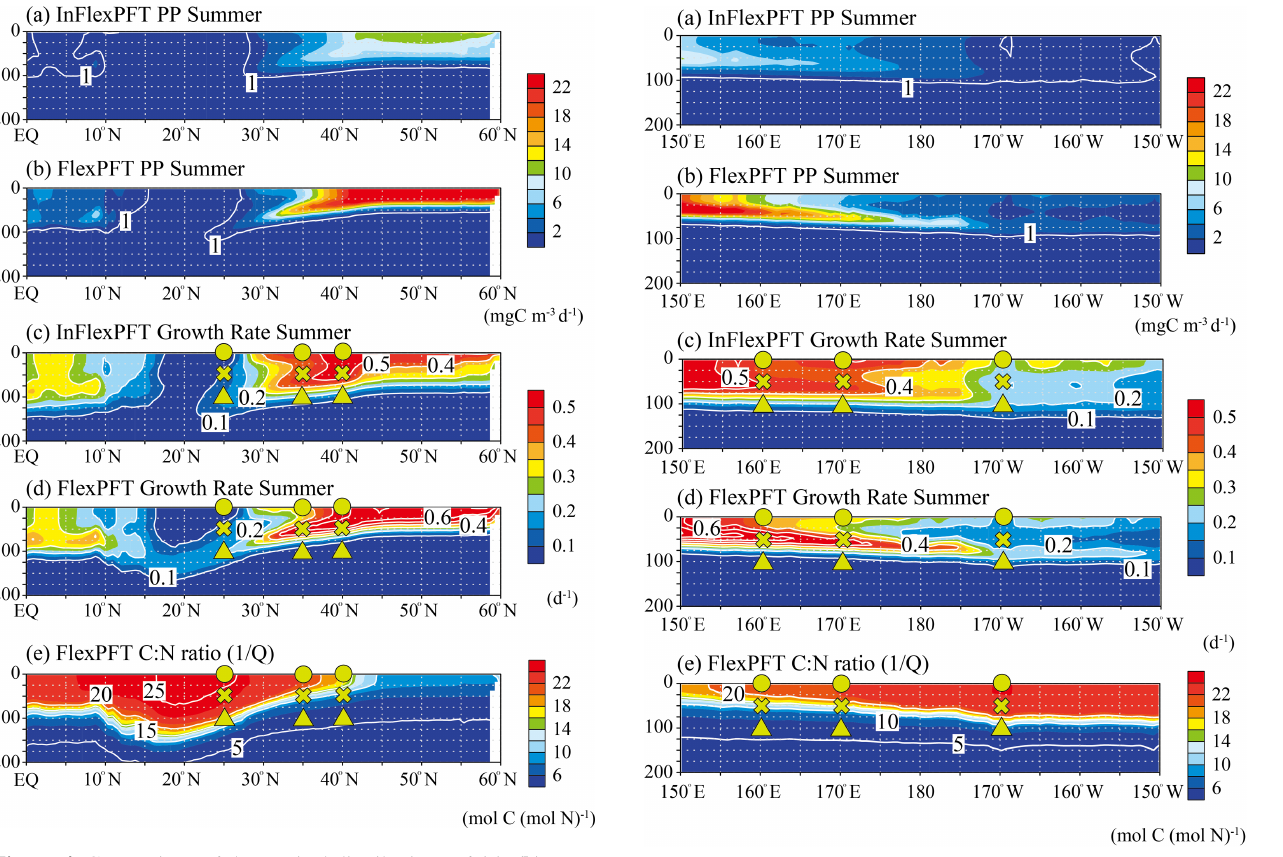
Figure 5. Comparison of the vertical distributions of (a) – (b) sum- mer primary production (mg Cm − 3 d − 1 ) and (c) – (d) summer phy- toplankton growth rate (d − 1 ) between the two models, and (e) the vertical distribution of summer C:N ratio in the FlexPFT, along the location of white crosses (east–west section) in Fig. 1. These fig- ures show the average values for the summer during the 2000–2019